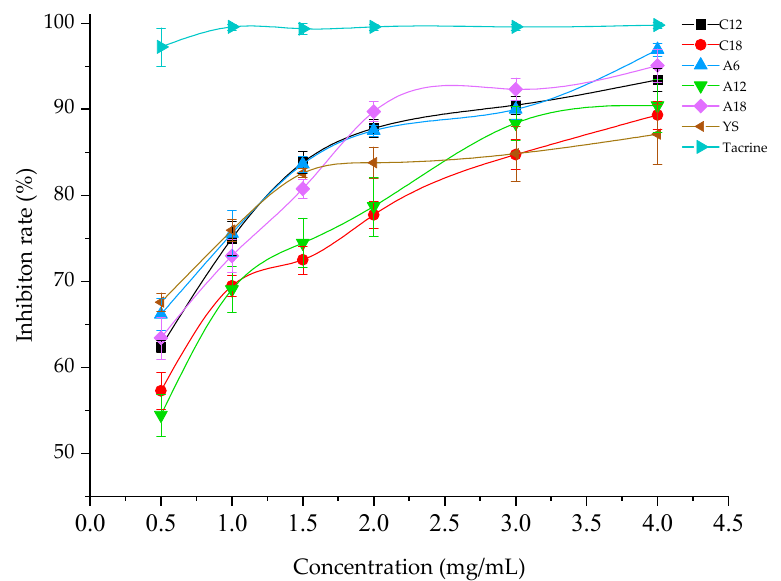
Figure 5. Inhibition rate of acetylcholinesterase activity variation with extract concentration (C12 and C18 represented agarwood produced by A. crassna after 12 and 18 months of inoculation, respectively; A6–A18 represented agarwood produced by A. sinensis after 6, 12, and 18 months of inoculation, respectively; YS represented wild agarwood).